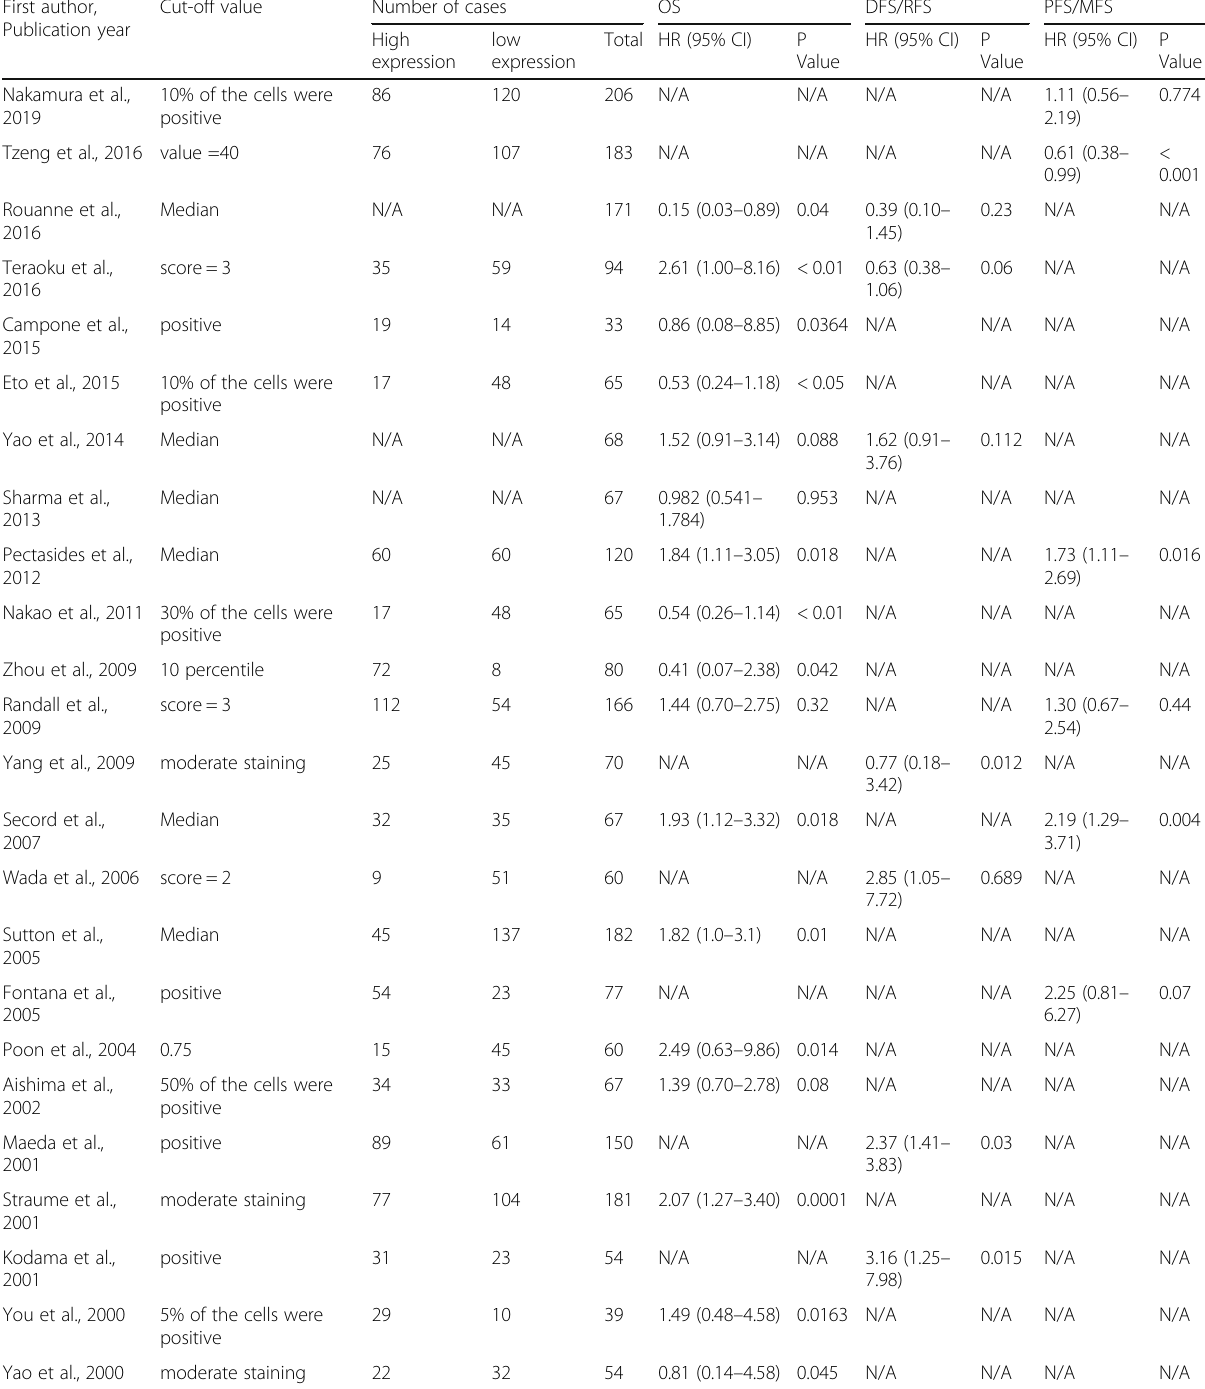
Table. 2 HRs and 95% CIs of cancer prognosis and progression associated with TSP-1 expression in included